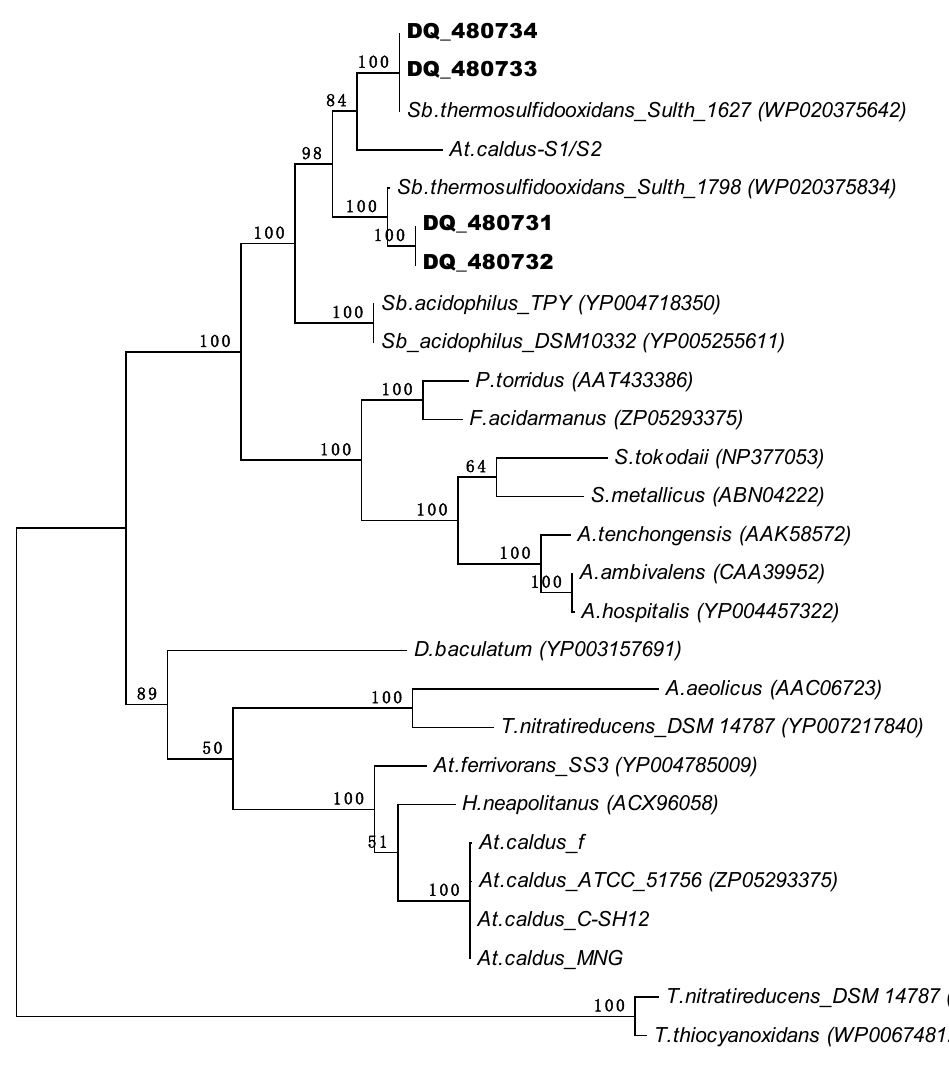
Figure 2. Maximum likelihood phylogenetic tree showing relationship amongst bacterial and archaeal Sor proteins. Sor aminoacidic sequences of Sb. thermosulfidooxidans DSM 9293 T (WP_020375642 and WP-_020375834), A. aeolicus VF5 (NP_21332), H. neapolitanus